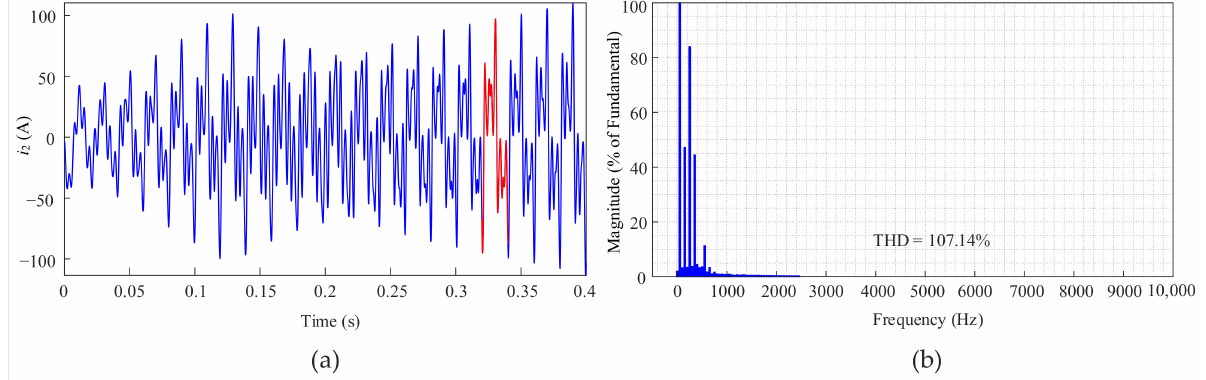
Figure 9. Simulation waveform of the grid-side current i L 2 and its FFT analysis result in Simulation 3 when L g = 2.6 mH and with the 5th order resonance controller applied: ( a ) The simulation waveform; ( b ) the FFT analysis result.